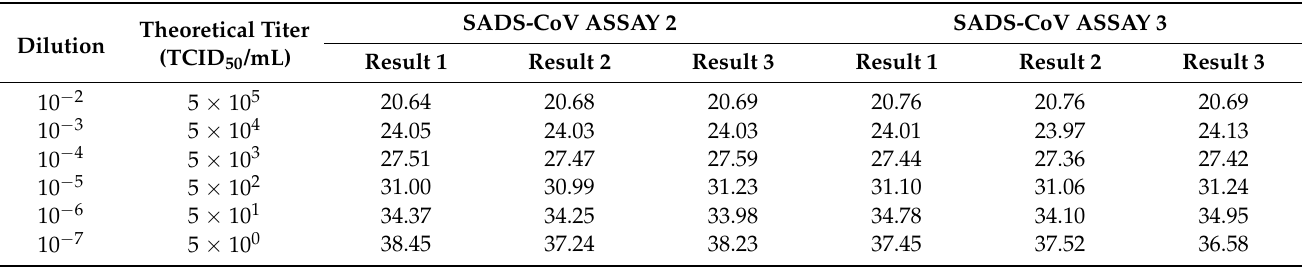
Table 3. Analytical sensitivity of Singleplex SADS-CoV PCR assays 2 and 3 by testing serial dilutions of a SADS-CoV cell culture isolate